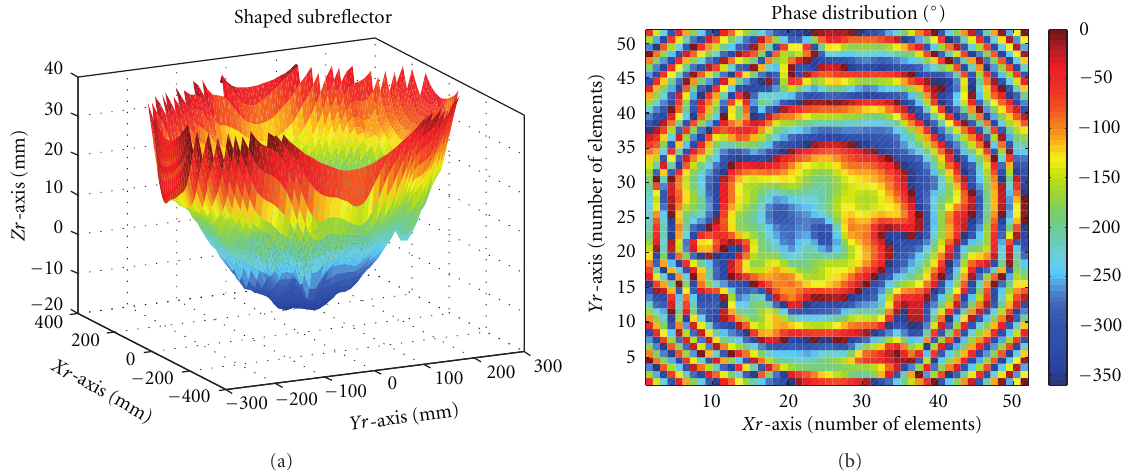
Figure 8: Shaped ellipsoid as subreflector (a) and phase distribution of the reflection coe ffi cient for the equivalent reflectarray at 11.95 GHz (b).